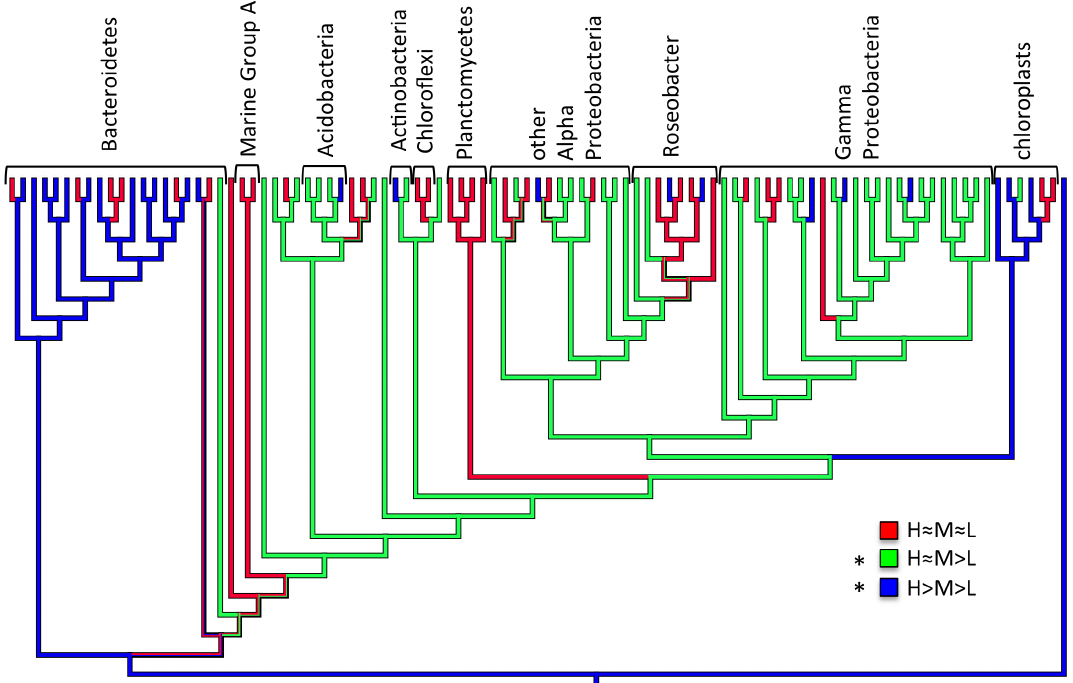
Figure 5. Amino acid incorporation trophic strategies mapped onto a maximum parsimony unrooted 16S rRNA gene phylogeny of taxa from a SF Bay seawater sample. Ancestral states were identified by parsimony. Asterisks indicate strategies with a statistically clustered distribution indicating a phylogenetic signal. Figure S1 (a) Hybridization Corrected Enrichment (HCE) values and (b) percent change from one value to the next lowest, for 107 taxa at the high amino acid concentration, ranked from high to low. Arrow indicates the cutoff used to delineate highly active versus less active tax, which corresponds to 50% of the maximum. Figure S2 Result of phylogenetic distribution of taxa assigned to the ‘‘H < M . L’’ strategy (a) and the ‘‘H . M . L’’ strategy (b) on the 16S phylogeny, showing the frequency distribution of parsimony scores from 1000 randomly shuffled character states. The parsimony score for the actual dataset is indicated by the arrow and was significantly different from the null distribution based on an F-test, indicating a phylogenetic signal. Figure S3 Ribosomal Operational Taxonomic Units (OTUs) targeted by Chip-SIP phylogenetic microarray, including Gen- bank accession numbers of representative sequences, taxonomy,